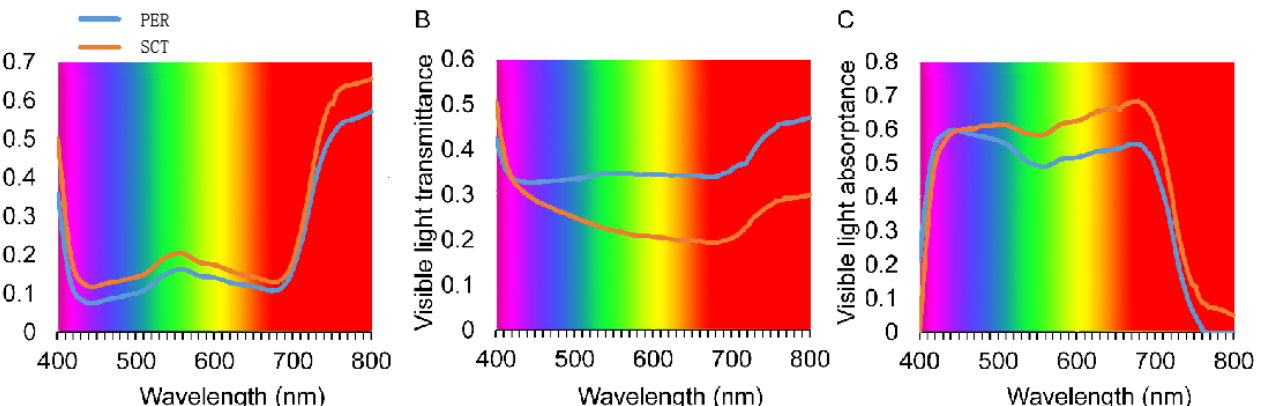
Figure 4. Light interception rates of SCT (single-curtain training system) ( A ) and PER (pergola) and SCT ( B ) at veraison. Data are means ± SD of three independent replicates. Different letters indicate a significant difference at p < 0.05 as determined by Duncan’s multiple range test.